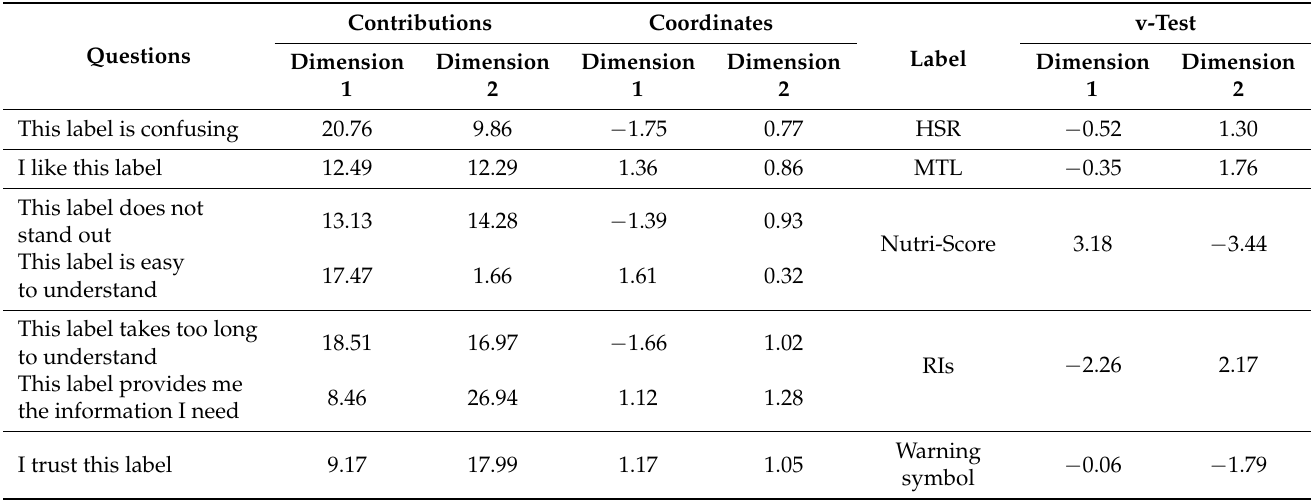
Table 4. Comparison of the average score and the standard deviation of each statement by